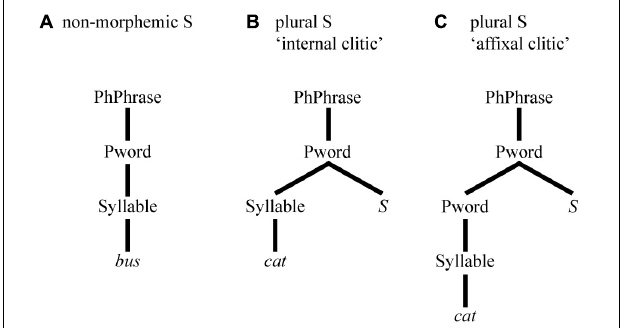
FIGURE 1 | Prosodic configuration for (A) non-morphemic and (B,C) plural S.